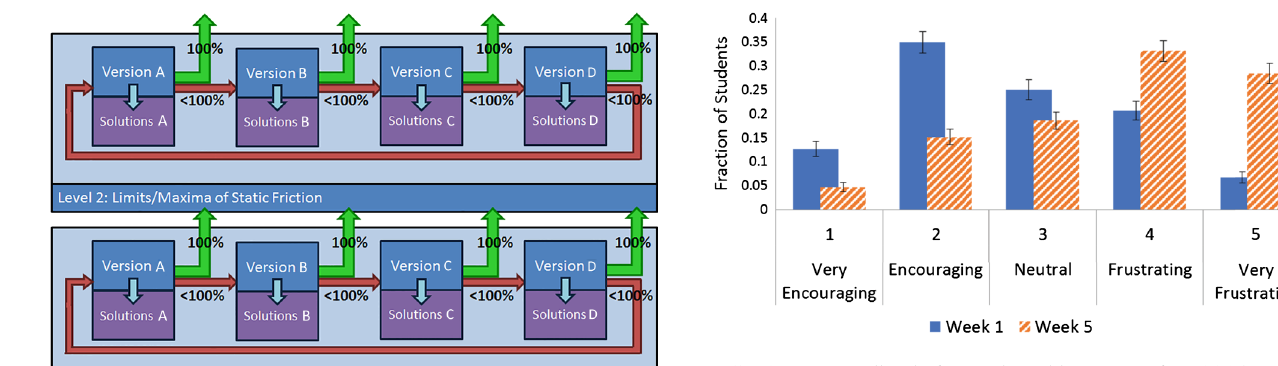
FIG. 2. Normalized frustration histogram for 2014 tested over time: Students responded to the question, “ Which statement best reflects your experience working through the mastery homework?